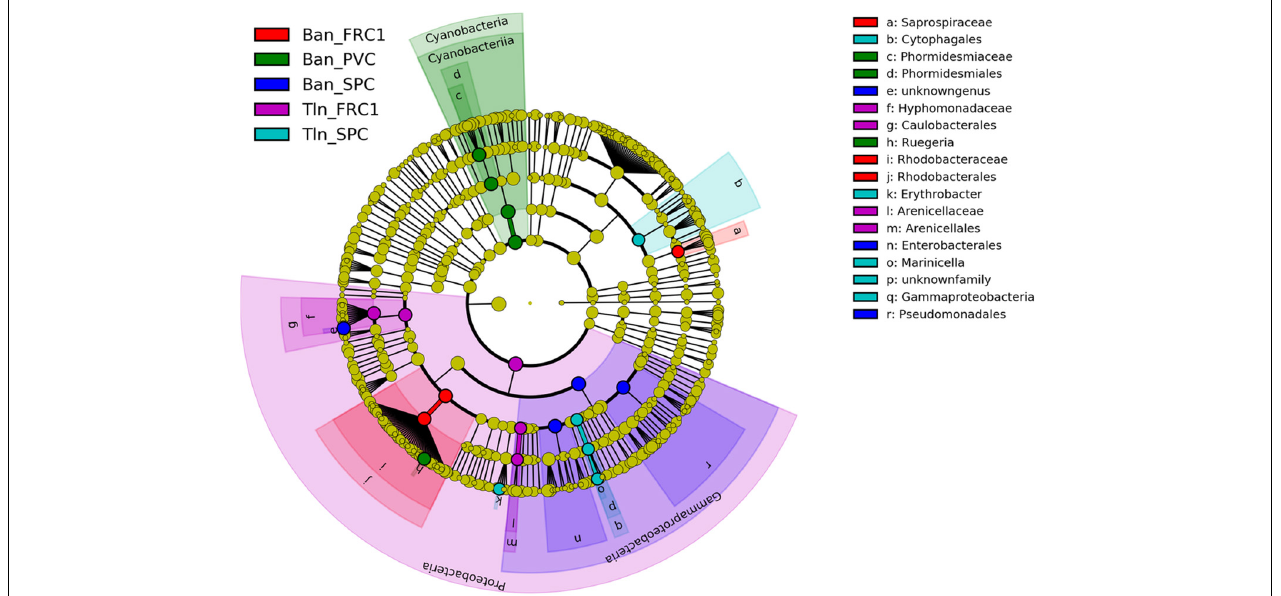
FIGURE 7 | LefSe analysis after 75 days of immersion at Toulon and Banyuls for the three surfaces (PVC, SPC1, and FRC1).